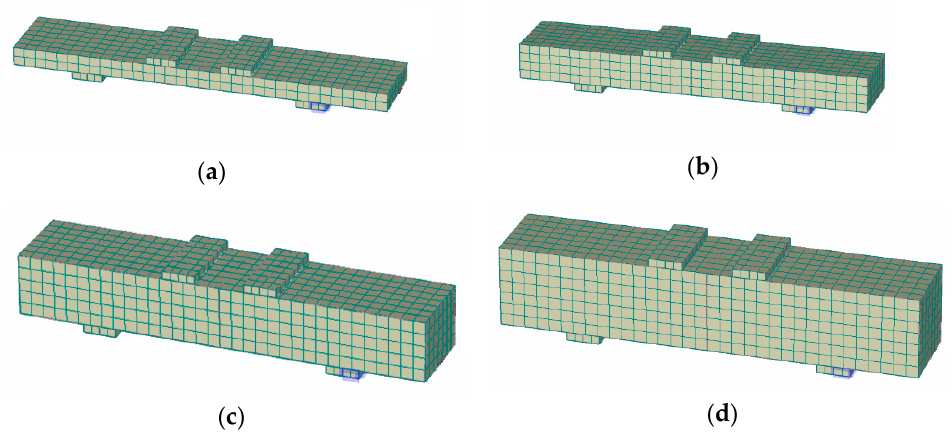
Figure 12. Numerical models for UHPFRC-1 prisms ( a ) 25 × 100 × 500 mm, ( b ) 50 × 100 × 500 mm, ( c ) 75 × 100 × 500 mm, and ( d ) 100 × 100 × 500 mm.